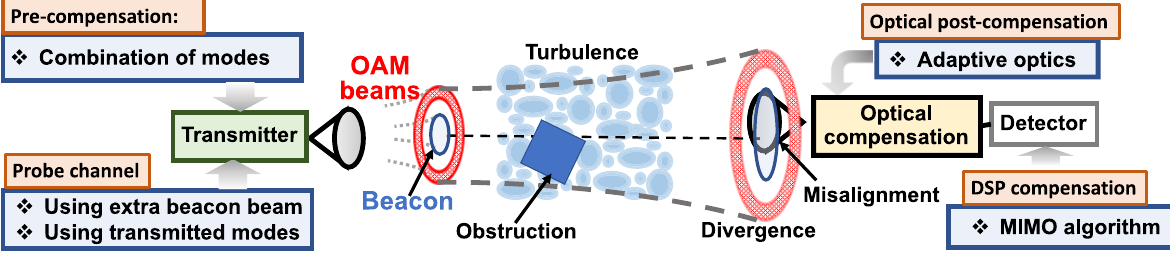
Figure 4: Various crosstalk compensation approaches in orbital-angular-momentum (OAM) – multiplexed